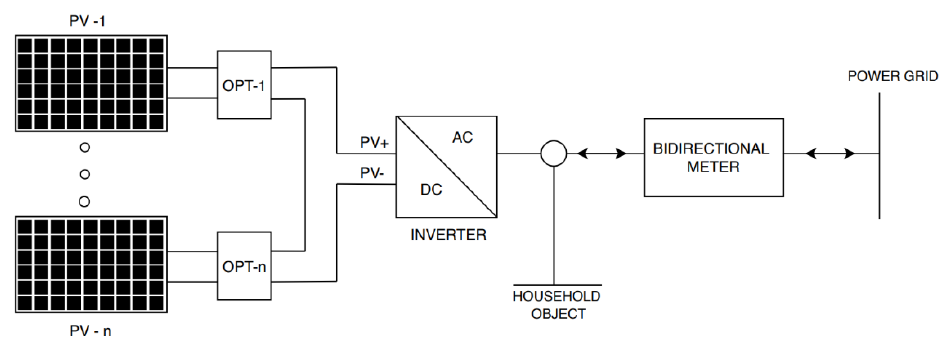
Figure 7. Schematic representation of a grid-connected PV system in a net-metering model. The model has been simulated for the cities of Zagreb and Split, where the PV systems are oriented to the south with panels fixed at 35°. According to [10], yearly in- (cid:2921)(cid:2907)(cid:2918) (cid:2921)(cid:2907)(cid:2918) plane insolation for Zagreb is 1513 and for Split it is 1826 . PV panels used for (cid:2923) (cid:3118) (cid:2923) (cid:3118) simulation are monocrystalline and have an efficiency of 18% with total system losses of 8% on an annual basis. The nominal power of one PV panel is 0.3 kWp and its surface area is 1.6 m 2 .